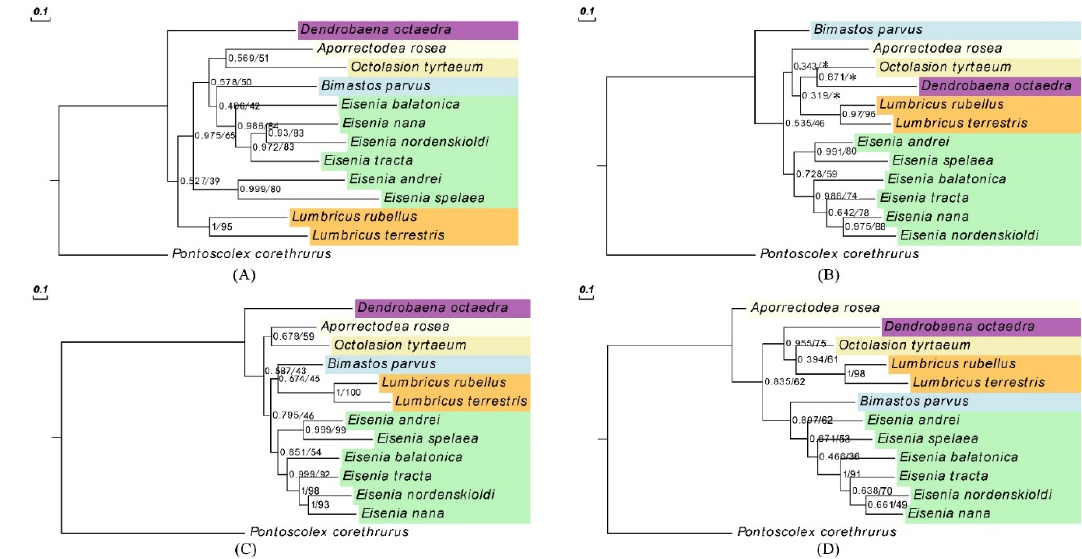
Figure 3. Mitogenomic phylogenetic trees of 12 Lumbricidae species and an outgroup ( P. corethrurus ) based on cox1 ( A ), cox2 ( B ), nd5 ( C ), and nd3 ( D ) using the BI method and ML method. Different colors indicate different genera. Numbers at nodes are statistical support values for BI (posterior probabilities)/ML (bootstrap values). * indicates clades not supported by the ML analysis.